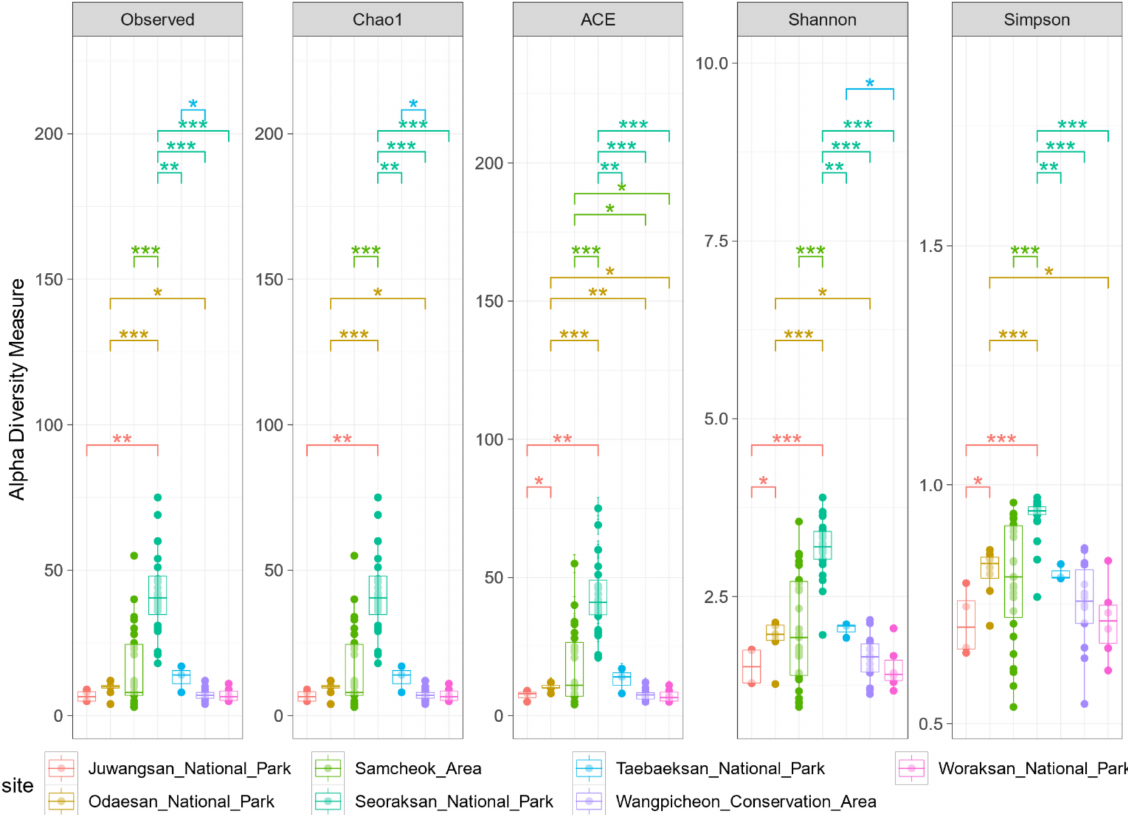
Figure 3. Alpha diversity indices of the gut microbial communities at each sampling site. * p < 0.05, ** p < 0.01, *** p < 0.001.